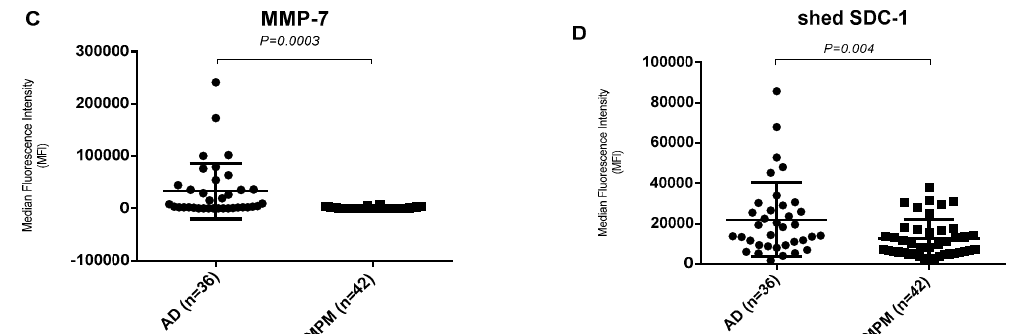
Table 1. Parameter estimates of logistic regression model. MMP-7 has higher predictive value for distinguishing malignant pleural mesothelioma from adenocarcinoma, based on estimate and p -value. Figure 3. Di ff erent biomarkers for distinguishing malignant mesothelioma from metastatic adenocarcinoma patients. ( A , B ) Levels of Galectin-1 and Mesothelin are significantly higher in pleural e ff usion from malignant pleural mesothelioma (MPM) patients ( n = 42) compared with adenocarcinoma (AD) patients ( n = 36). ( C , D ) Levels of MMP-7 and shed SDC-1 are significantly lower in malignant pleural mesothelioma patients ( n = 42) compared with adenocarcinoma patients ( n = 36). Significance was assessed by two-tailed t -test at p ≤ 0.05.